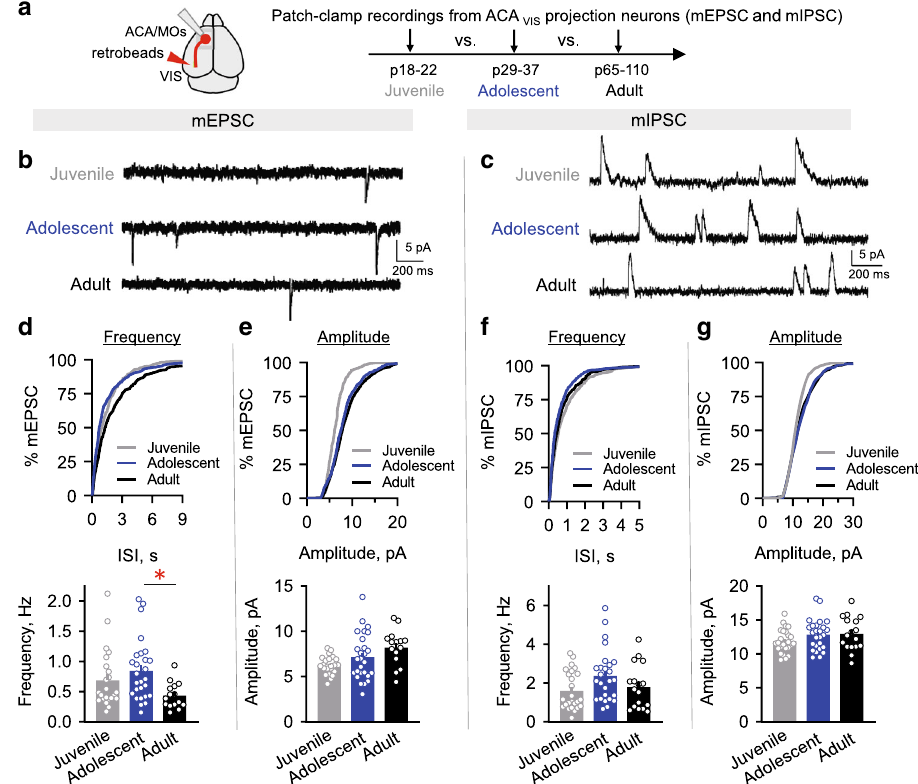
Fig. 1 Adolescent ACA VIS projection neurons receive greater excitatory drive. a Developmental changes in excitatory and inhibitory synaptic drive onto top-down ACA VIS projection neurons were assessed cross-sectionally. Slice patch-clamp recordings were performed from ACA VIS projection neurons, fl uorescently labeled by retrobeads injected in the VIS, on ACA/MOs brain slices at p20.3 ± 0.3 in average (p18 – 22) for Juvenile group, at p32.7 ± 0.4 in average (p29 – 37) for Adolescent group, and at p78.1 ± 4.3 in average (p65 – 110) for Adult group. Miniature excitatory postsynaptic currents (mEPSC) and miniature inhibitory postsynaptic currents (mIPSC) were recorded in the presence of TTX at − 70 and 0 mV, respectively. b , c Representative traces of mEPSC ( b ) and mIPSC ( c ) measured from ACA VIS neurons in three developmental age groups (for mEPSC: Juvenile: n = 23 cells from 5 biologically independent mice, Adolescent: n = 27 cells from 11 biologically independent mice, Adult: n = 15 cells from six biologically independent mice; for mIPSC: Juvenile: n = 25 cells from 5 biologically independent mice, Adolescent: n = 26 cells from biologically independent 11 mice, Adult: n = 17 cells from six biologically independent mice). Cumulative distribution (top) and averaged data (bottom) of mEPSC frequency ( d ) and mEPSC amplitude ( e ) in three age groups. Average mEPSC frequency were signi fi cantly higher in adolescent mice compared to adult (one-way ANOVA F 2,62 = 4.099, P = 0.021, post hoc Tukey test P Juv-Adoles = 0.43, * P Adoles-Adult = 0.016). While average mEPSC amplitude shows overall age effect, there was no signi fi cant difference between adolescence and adulthood (one-way ANOVA F 2,62 = 4.573, P = 0.014; post hoc Tukey test P Juv-Adoles = 0.24, P Adoles-Adult = 0.23). Cumulative distribution (top) and averaged data (bottom) of mIPSC frequency ( f ) and mEPSC amplitude ( g ) in three age groups show trending yet no signi fi cant difference in average mIPSC frequency (one-way ANOVA F 2,65 = 3.060, P = 0.054), and no difference in average mIPSC amplitude (one-way ANOVA F 2,65 = 1.773, P = 0.18). Data in d-g are presented as mean ± s.e.m. See related Supplementary Fig. 1. Source data are provided as a Source data